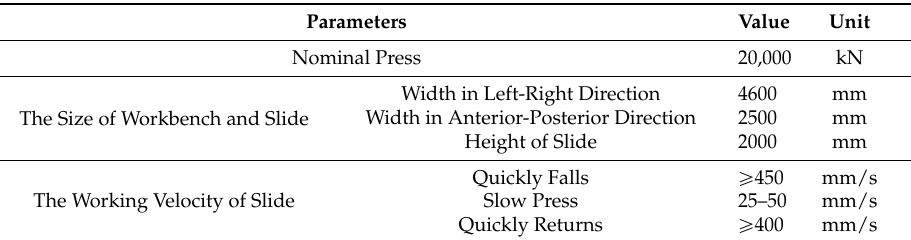
Table 3. The parameters of movable crossbeam of the hydraulic press.